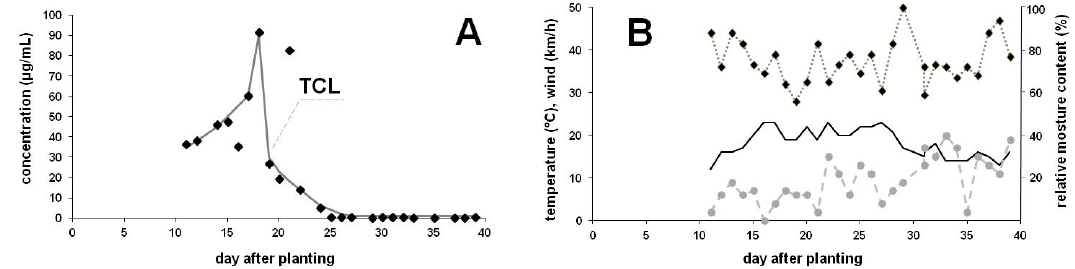
Figure 1. Neonicotinoid thiacloprid (TCL) occurrence from the seed coating in a commercial maize variety (LG 30.369) cultivated under field conditions (sown in May). ( A ): Concentration of TCL ( µ g / mL) in the guttation liquid of maize as a function of time after sowing. ( B ): Meteorological parameters during the sampling period recorded at 7:30 a.m. each day. Relative moisture content (%, ♦ dotted line), temperature (°C, continuous line) and wind speed (km/h, • dashed line).